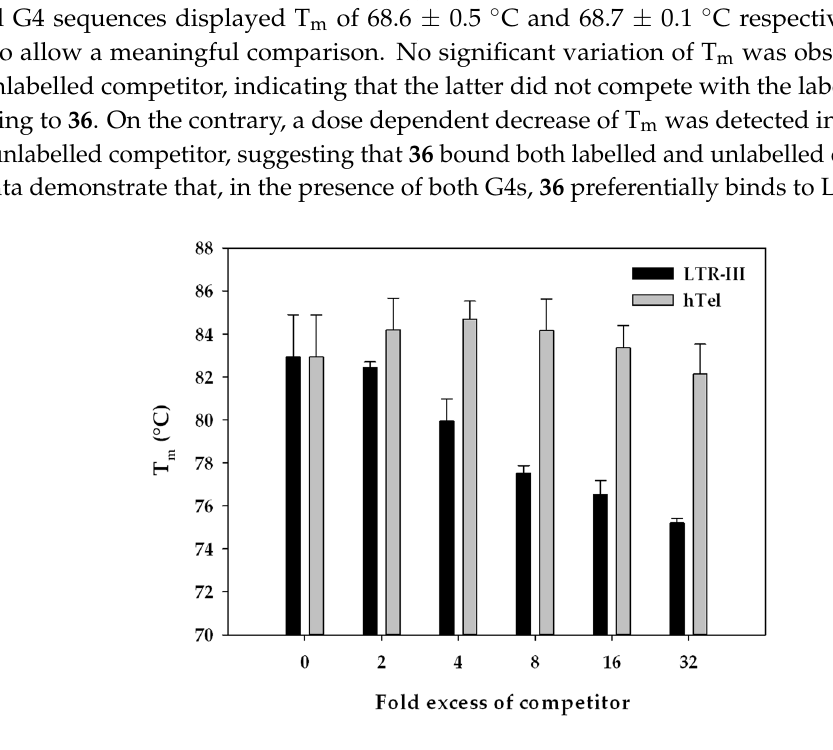
Figure 5. Competition analysis by FRET assay. 5 ′ -FAM- and 3 ′ -TAMRA-labeled LTR-III G4 (0.25 μ M) was mixed with increasing concentrations (0–32-fold excess) of unlabelled competitor LTR-III or hTel and a constant amount (25 μ M) of 36 .